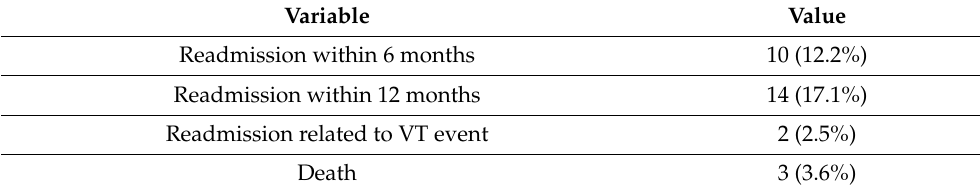
Table 3. Cont. Variable